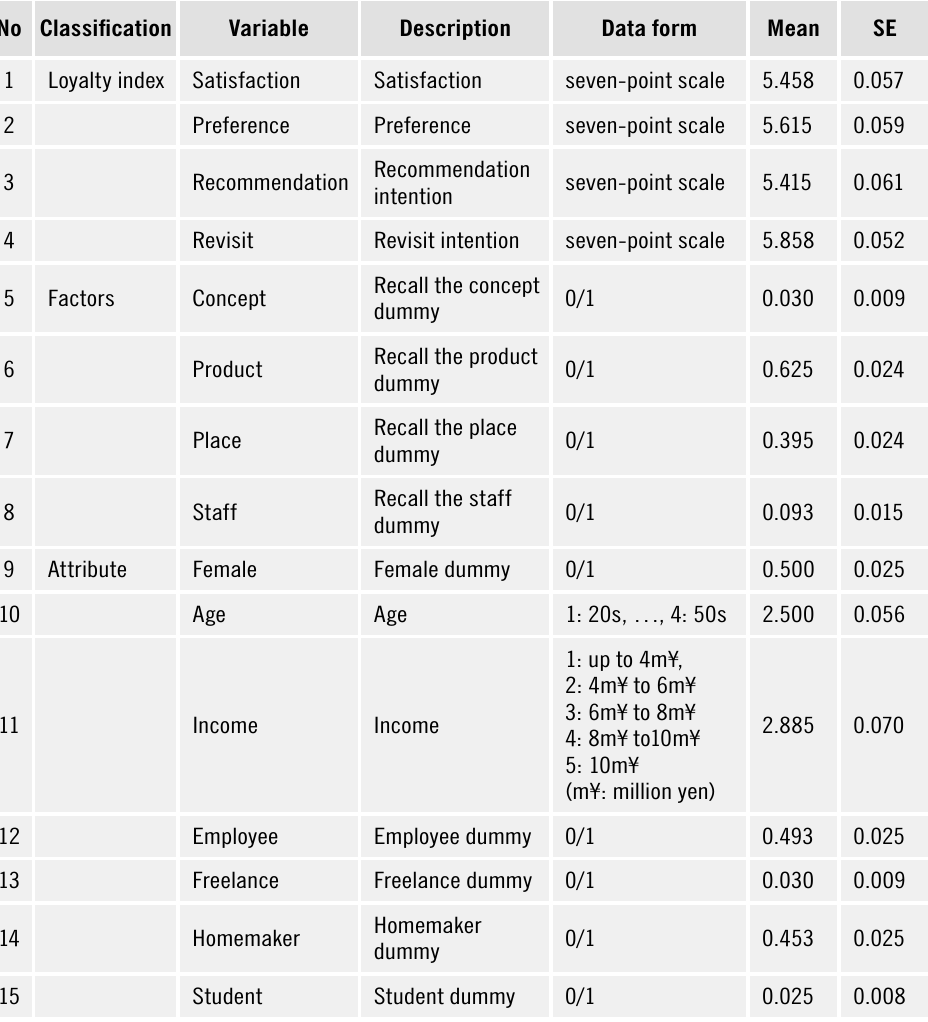
Table 4. Number of detections of each factor No